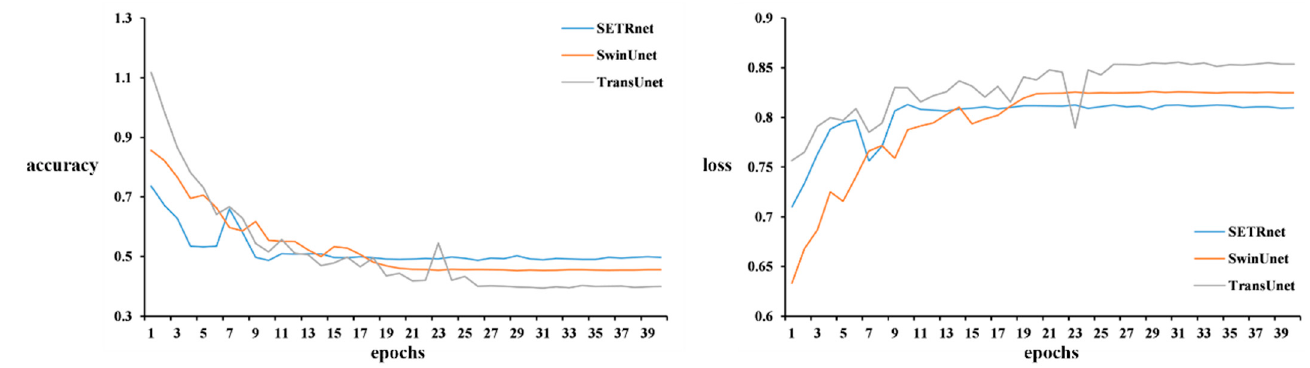
Figure 13. Training process of transformers on the Vaihingen data set.